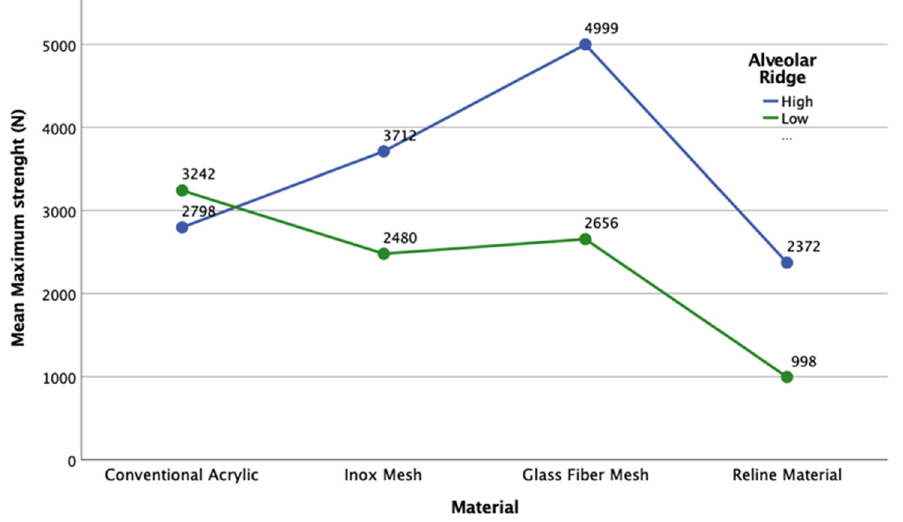
Figure 8. Average values of the maximum masticatory strength of each type of material in the two groups.